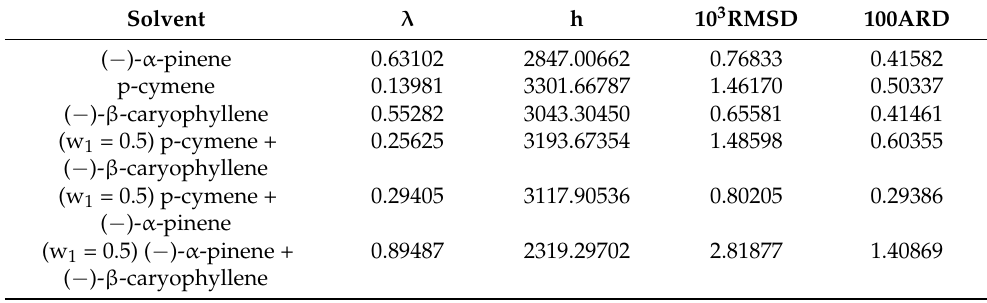
Table 5. Regression results and model parameters of the λ h model of dehydroabietic acid in solvents.